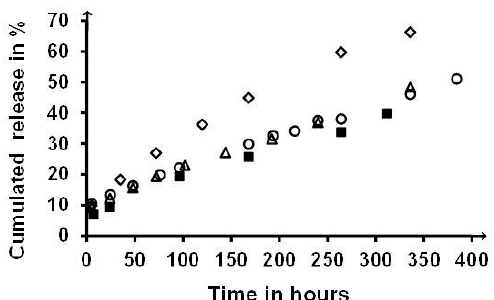
Figure 10. Comparison of Risperidone release profiles from different hydrogels (1 cm 3 containing 30 mg of Risperidone) in gently stirred 600 cm 3 of iso-osmolar phosphate buffer at pH = 7.4 and 37 °C: ■ : PNAGA 1 at 6% W/V; ∆ COP50 0.1 at 6% W/V; ○ COP50 0.1 at 5 % W/V, and ◊ COP75 0.25 at 5% W/V. Profiles were averaged from duplicates, and from triplicate for the COP75 0.25 . Differences were all smaller than the data point